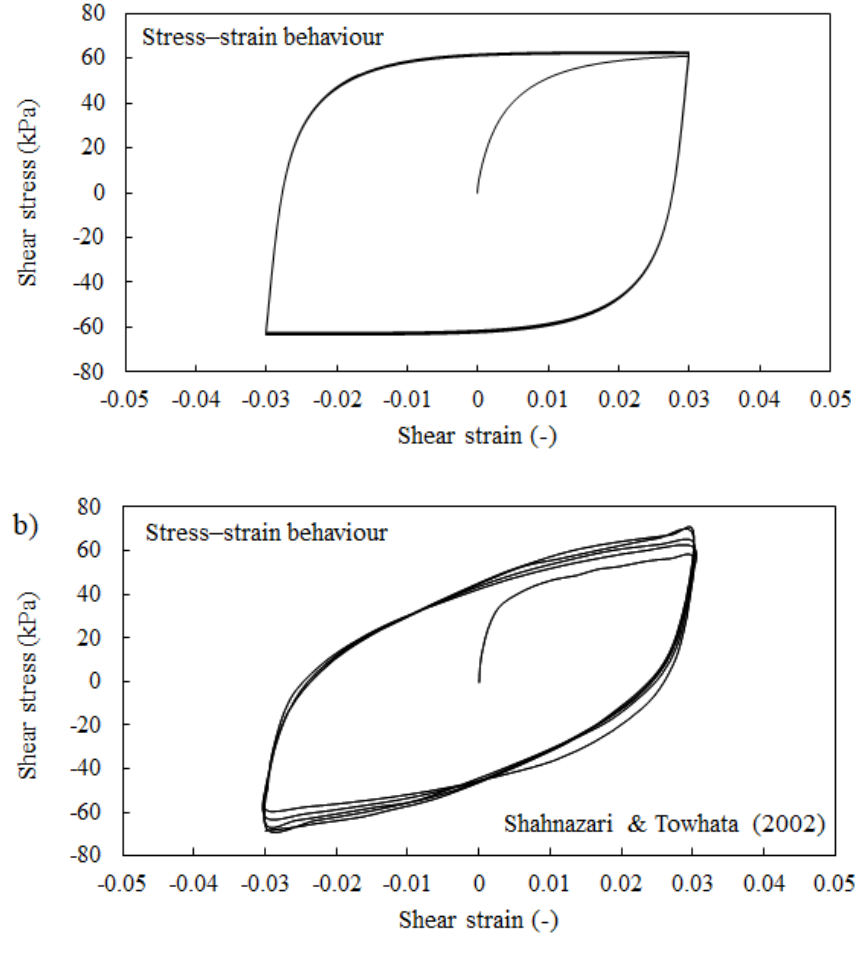
Figure A1: Comparison of a cyclic simple shear test simulated by the hypoplastic sand model and compared with experimental data from literature (Shahnazari & Towhata, 2002): a) stress–strain behaviour (simulation), b) stress–strain behaviour (experiment), c) volumetric response (simulation), d) volumetric response